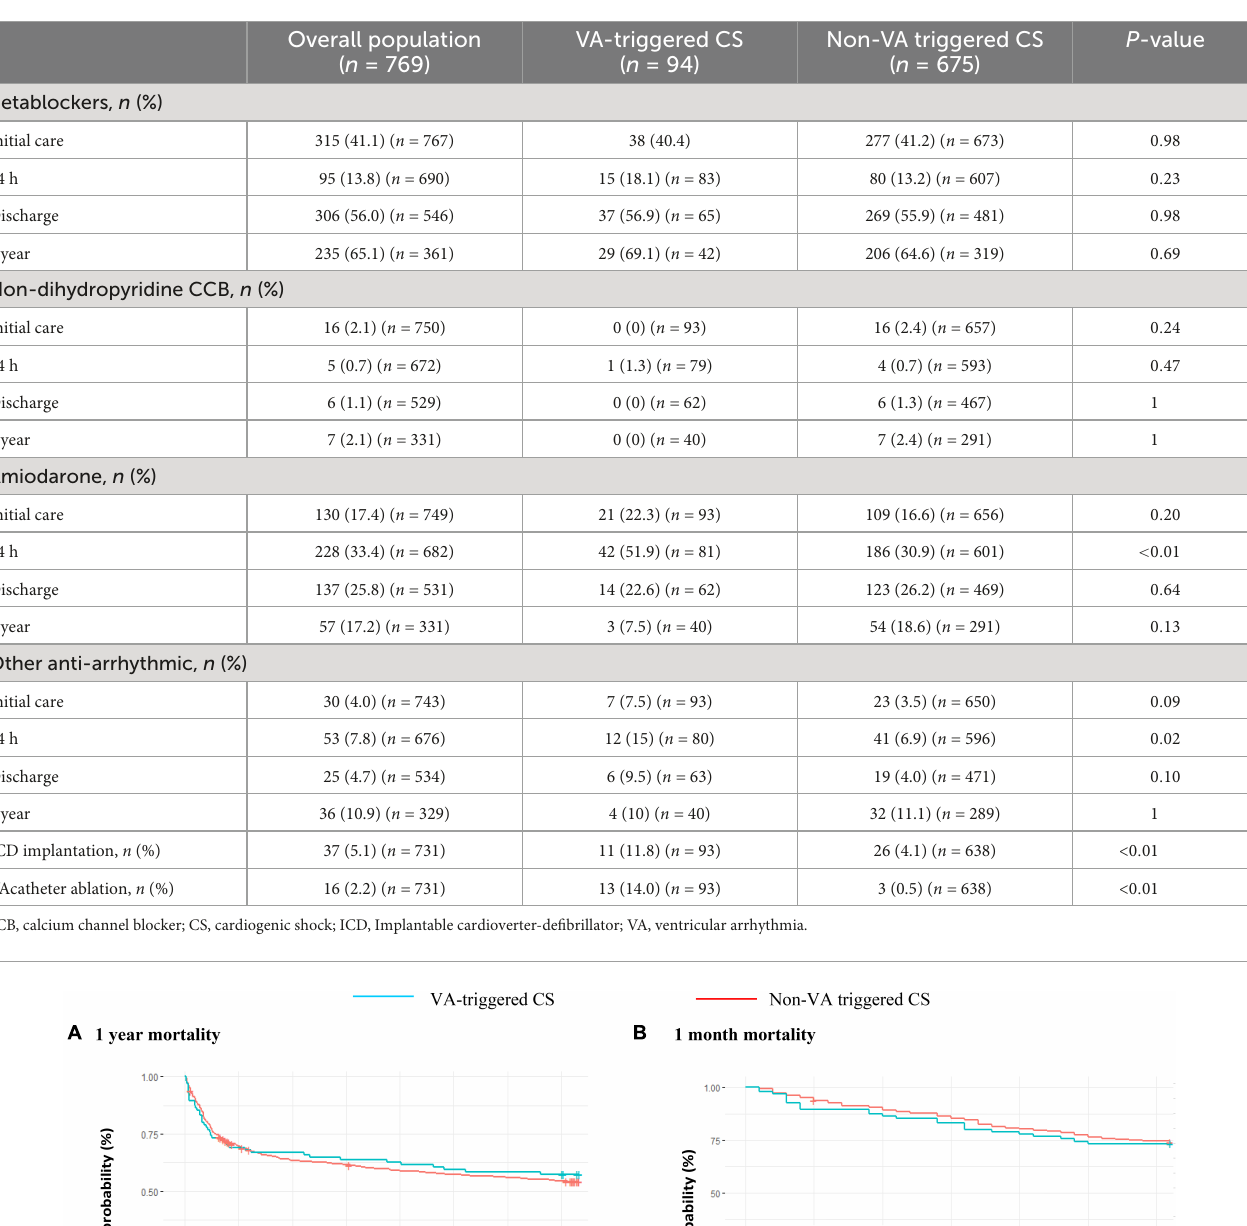
TABLE 4 Antiarrhythmic therapies according to cardiogenic shock triggers (VA vs. non-VA).